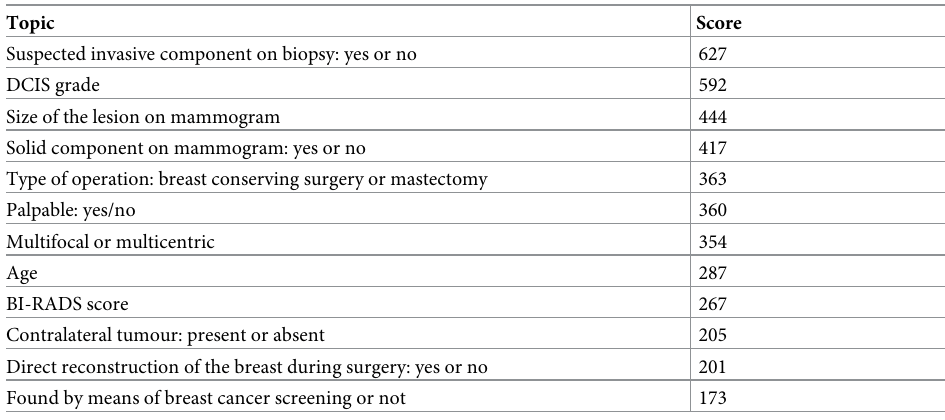
Table 3. Ranking of